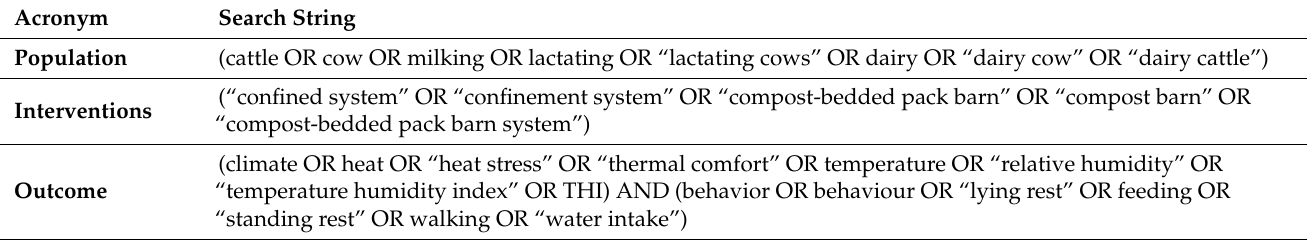
Table 1. Search term strings used for the final searches in the systematic